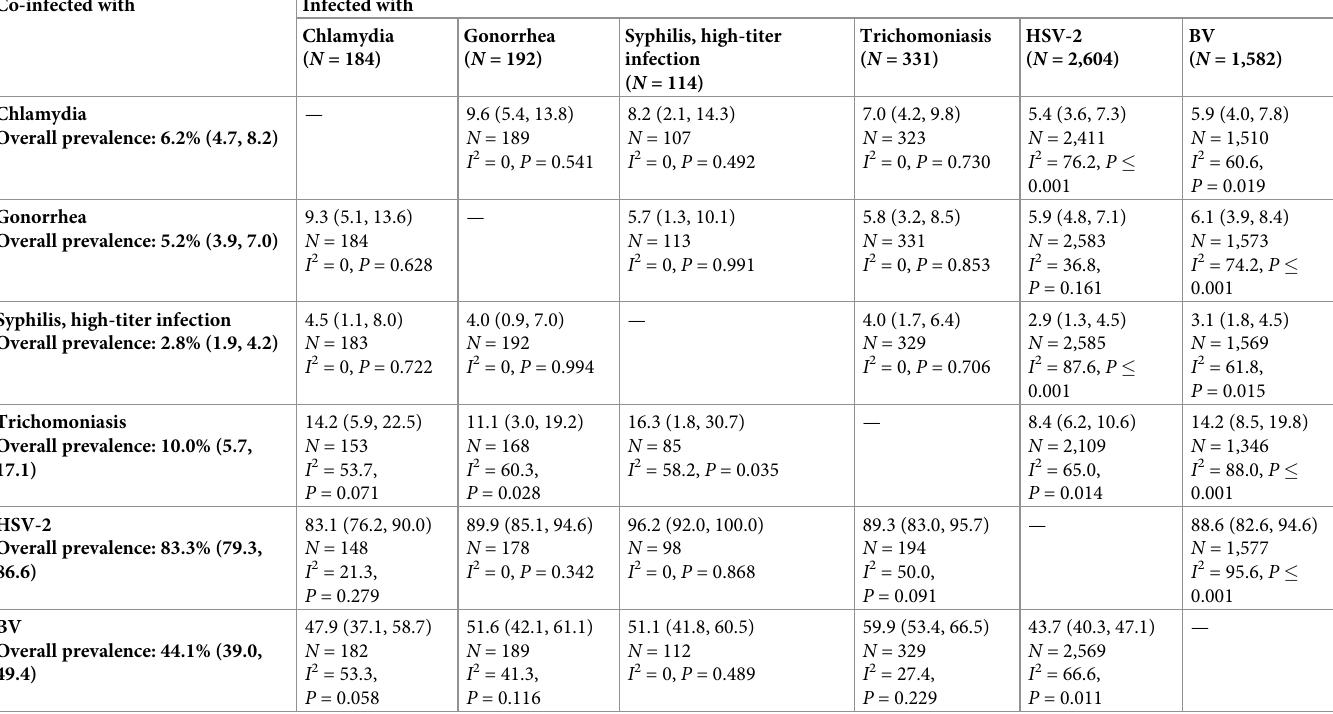
Table 9. Proportion of participants with each infection who are co-infected with an additional STI or BV among women aged 25–49 years in Eastern African higher-risk populations. Co-infected with